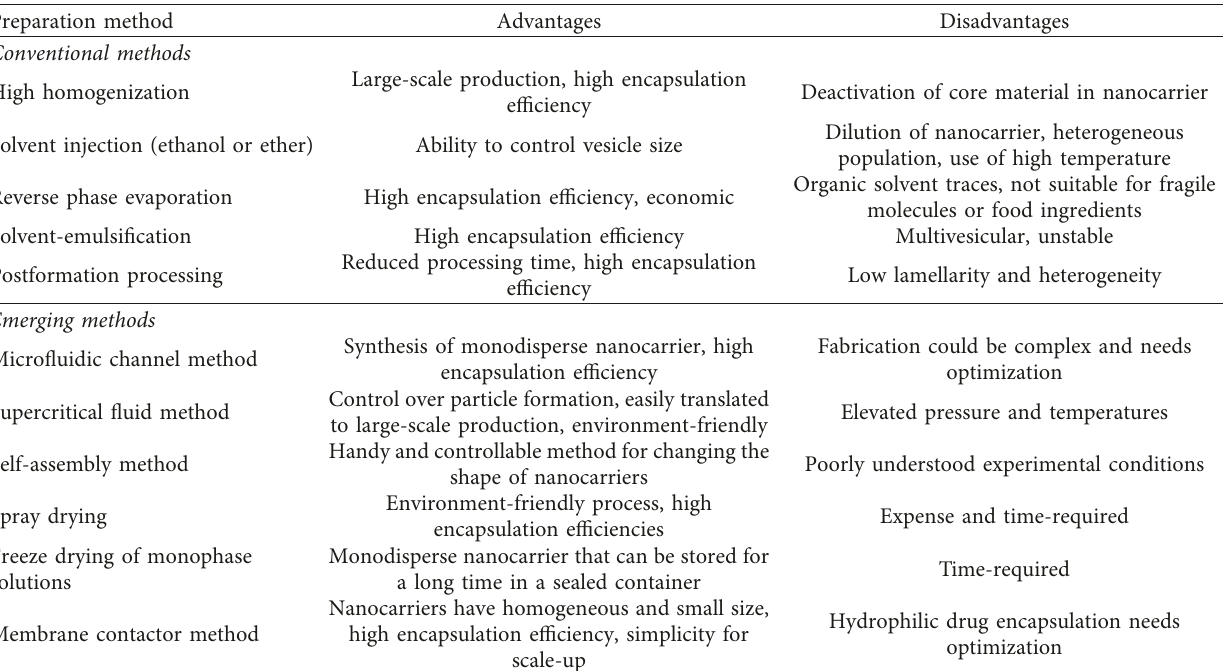
Table 2: Conventional and emerging methods for preparation of